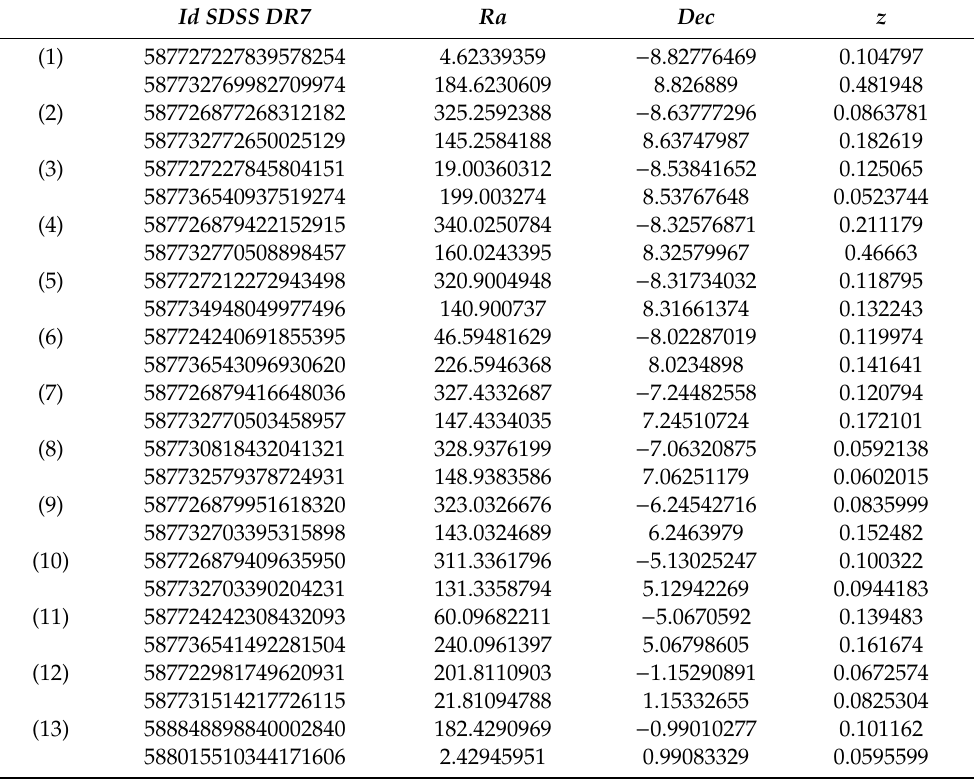
Table A2. Pairs of galaxies for the e ff ect of cosmic lens [36]. Id SDSS DR7 is objID identification number in the Sloan Digital Sky Survey. Accuracy is of 0.001 ◦ for ra and dec . The redshift z is indicated to make it easier to imagine the degree of asymmetry of the galaxy’s location on the circumference (null-geodesic) with respect to the observer on Earth. The candidate pair is valid if both galaxies in a pair are of the same